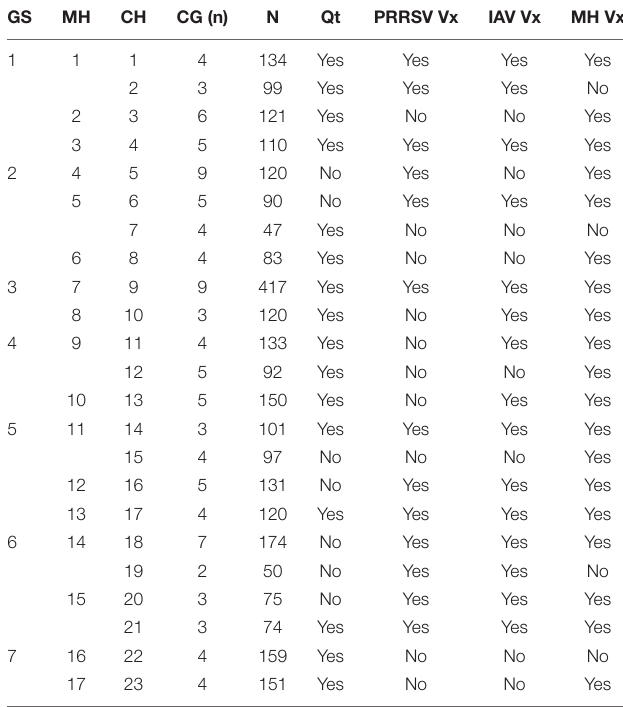
1 Pathogens potentially vaccinated for at each CG; GS, recoded ID for genetic supplier; MH, recoded ID for multiplier herd; CH, recoded ID for commercial herd; CG (n), number of contemporary groups; N, number of gilts per CG; Qt, quarantine, PRRSV Vx, CG vaccinated to Porcine Reproductive